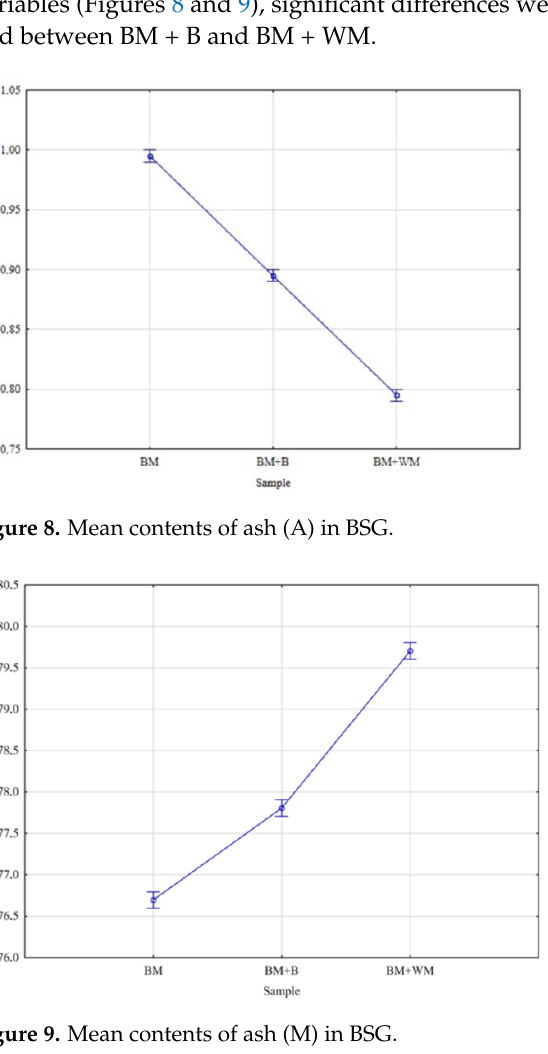
Figure 7. Mean contents of organic matter (A) in BSG.